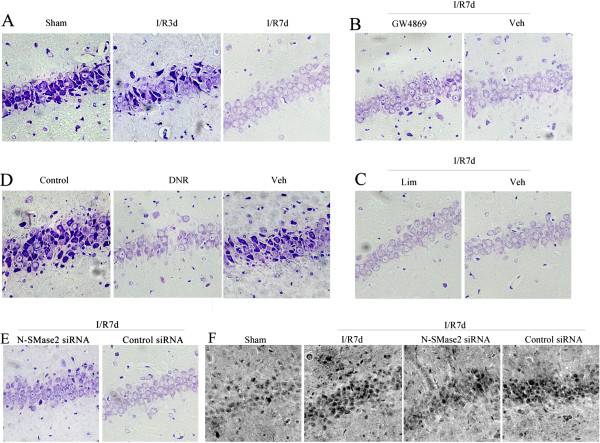
Effect of neutral sphingomyelinase 2 on ischemic neuronal damage associated with cerebral ischemia. Neuronal damage in the rat CA1 hippocampal area was detected in the different groups that received different treatments using Nissl staining. (A) Postischemic reperfusion of different durations (3 d and 7 d) and control groups. (B) and (C) Injection with GW4869, imipramine (Lim) and their solvent into the lateral ventricle, respectively, followed by 7-d postischemic reperfusion. (D) Normal group with daunorubicin (DNR) stimulus for 24 h. (E) Effect of neutral sphingomyelinase 2 (nSMase2) small interfering RNA (siRNA) and control siRNA on the rat CA1 hippocampal neurons postischemia. (F) Terminal deoxynucleotidyl transferase–mediated deoxyuridine triphosphate nick-end labeling assays showing apoptosis in the rat CA1 hippocampal neurons postischemia and effect of nSMase2 siRNA on them (n = 4).